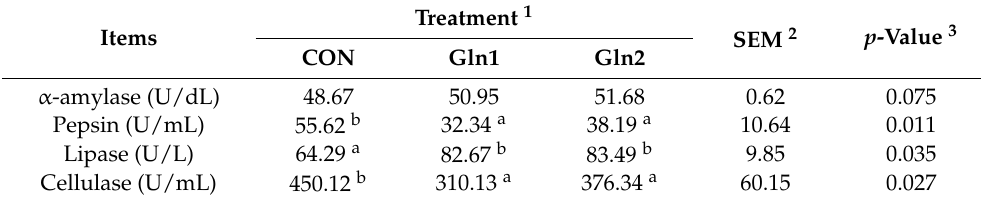
Table 3. Effect of adding Gln to high concentrate on rumen digestive enzyme activity of